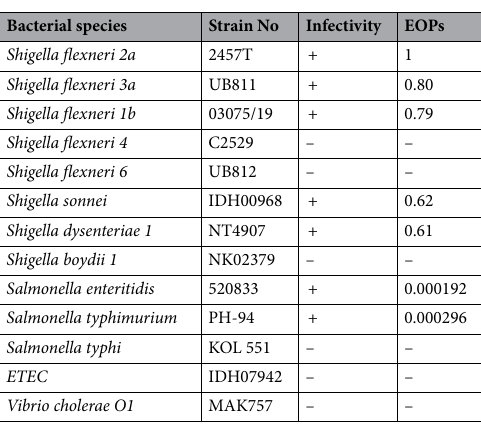
Table 1. Host range analysis of phage Sfk20. + = lysis; – = no lysis.